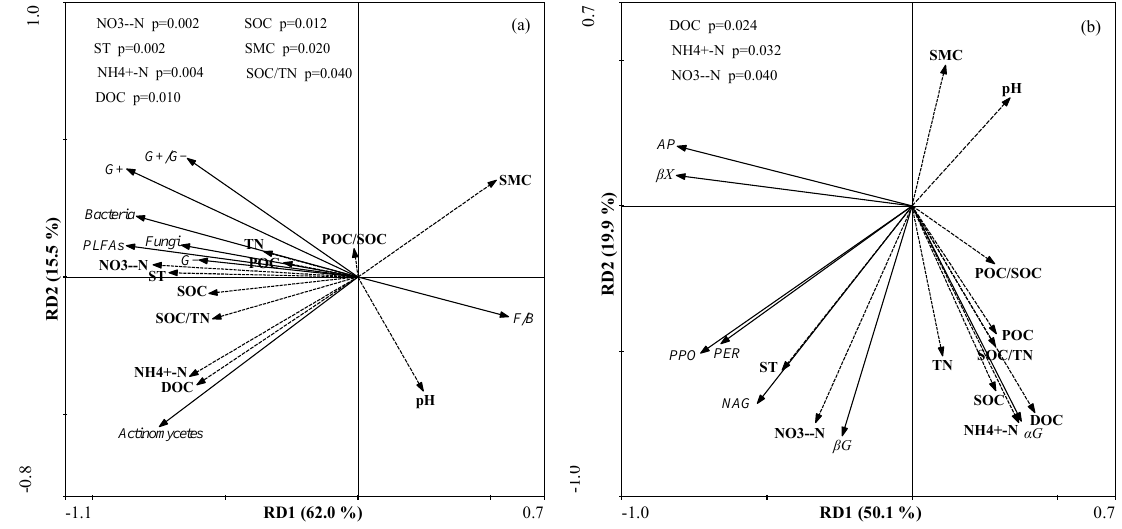
Figure 4. Redundancy analysis of all soil abiotic properties and PLFA contents (a) , and potential enzyme activities (b) . SMC: soil moisture content, pH: soil pH, NO − –N: soil nitrate nitrogen, NH + –N: soil ammonia nitrogen, TN: soil total nitrogen, DOC: soil dissolved 3 4